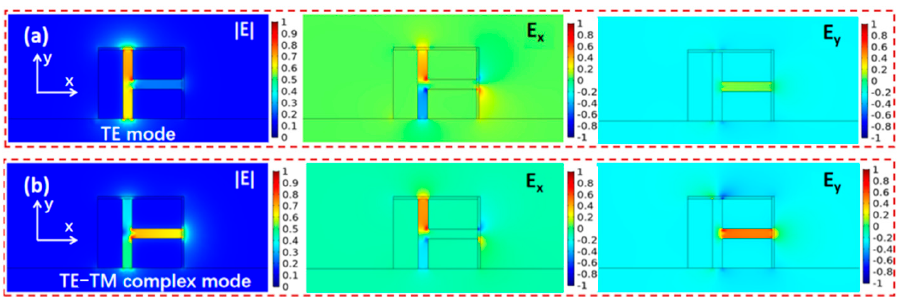
Figure 2. Electric field distributions of ( a ) TE mode and ( b ) TE-TM complex mode at the optical wavelength of 1550 nm.